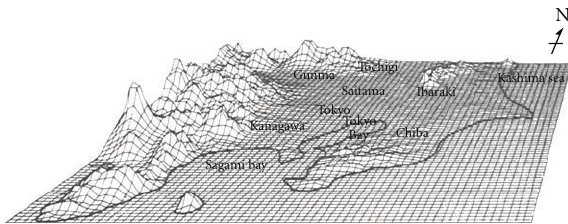
Figure 1: Topography of the Kanto area viewed from the south-east direction (source: Uno et al. [7]).